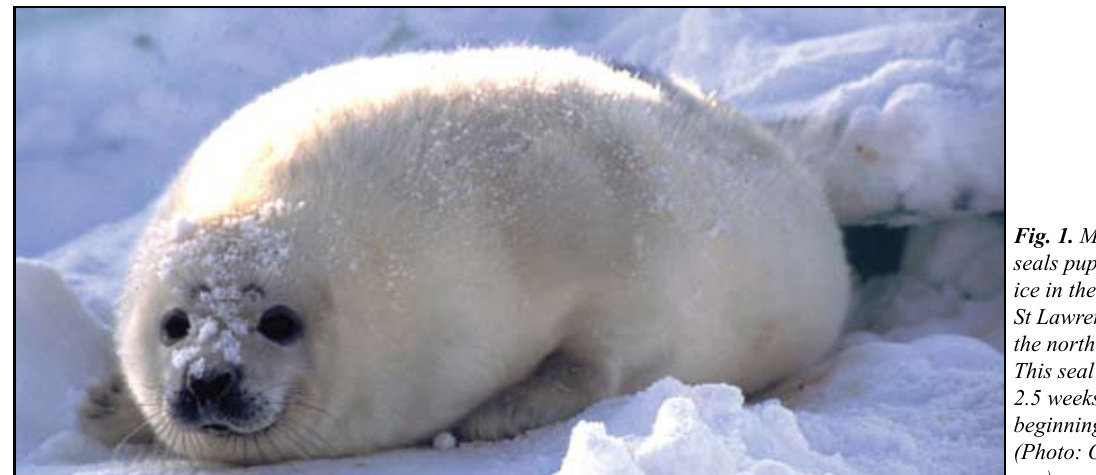
Fig. 1. Most grey seals pup on the ice in the Gulf of St Lawrence and in the northern Baltic. This seal is about 2.5 weeks old and beginning to moult. (Photo: Olle Karls -